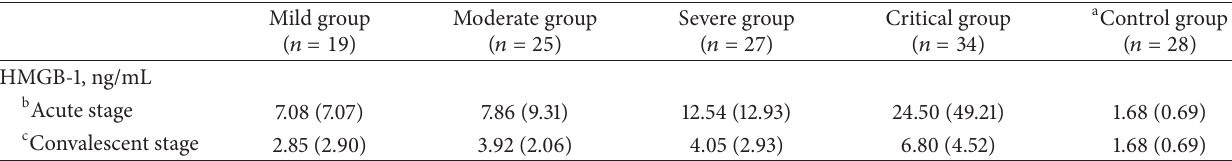
a The median level of the 28 control samples included. b